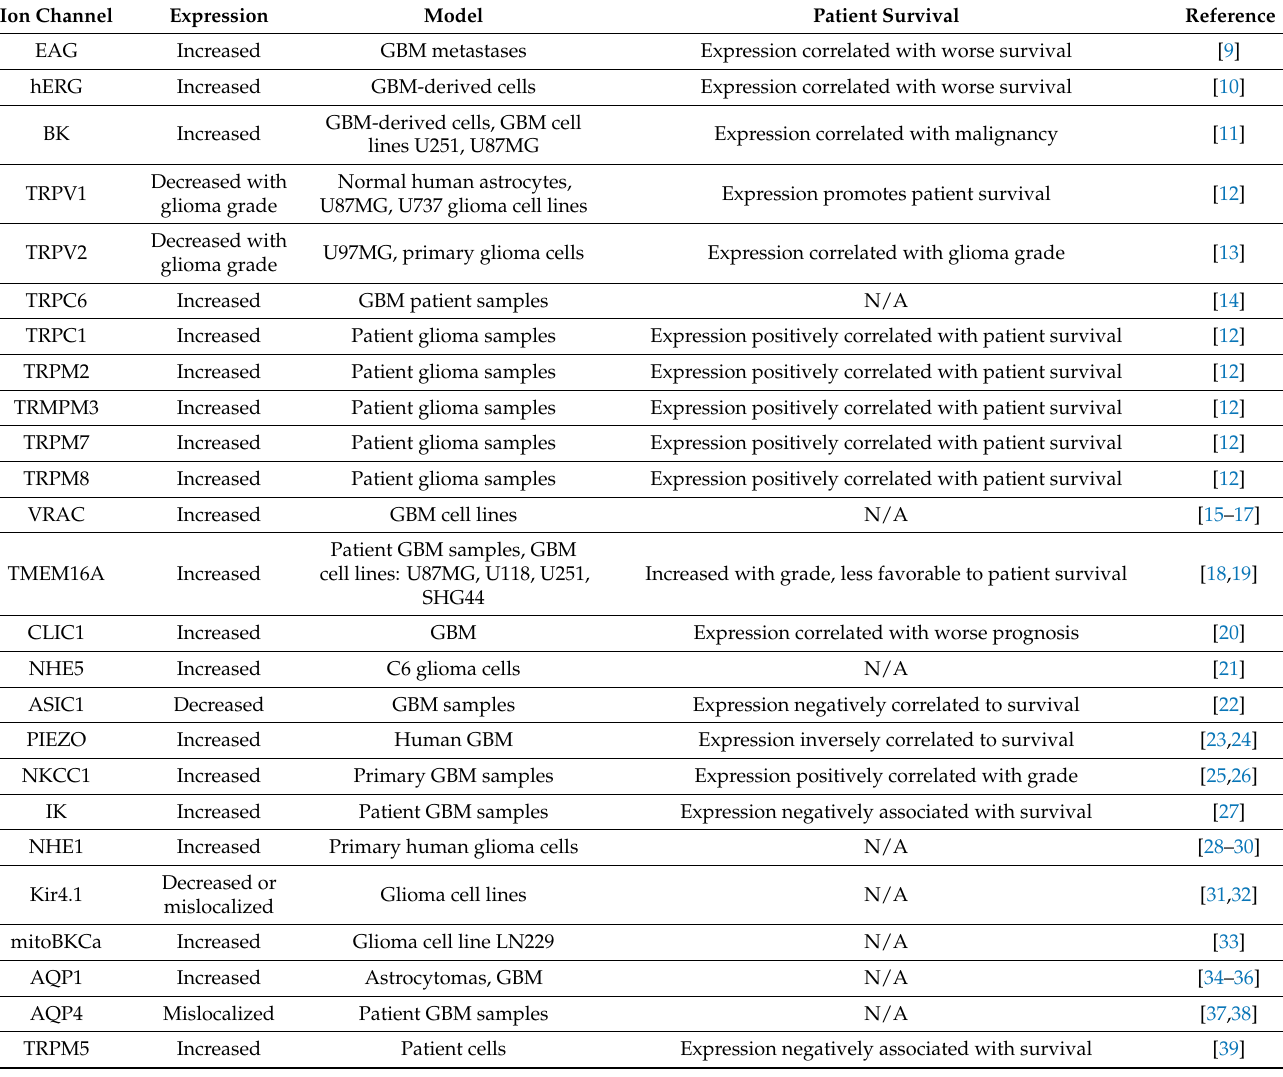
Table 1. Ion channel expression correlation with glioma grade and patient survival. Studies exam- ining patient glioblastoma samples (GBM), patient-derived cell lines, and glioma cell lines have found correlations with specific ion channel expression, suggesting that ion channels may serve as biomarkers. N/A, not